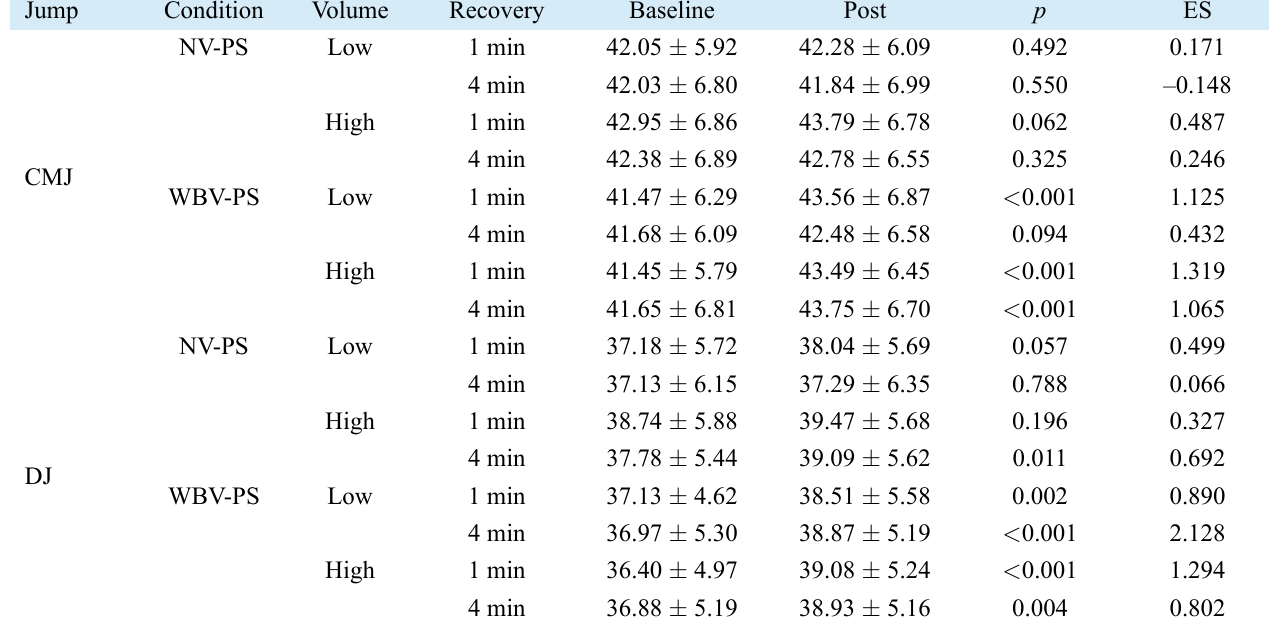
TABLE 1. Results (mean ± SD) of jumping performances at baseline and after each post-activation potentiation protocol.